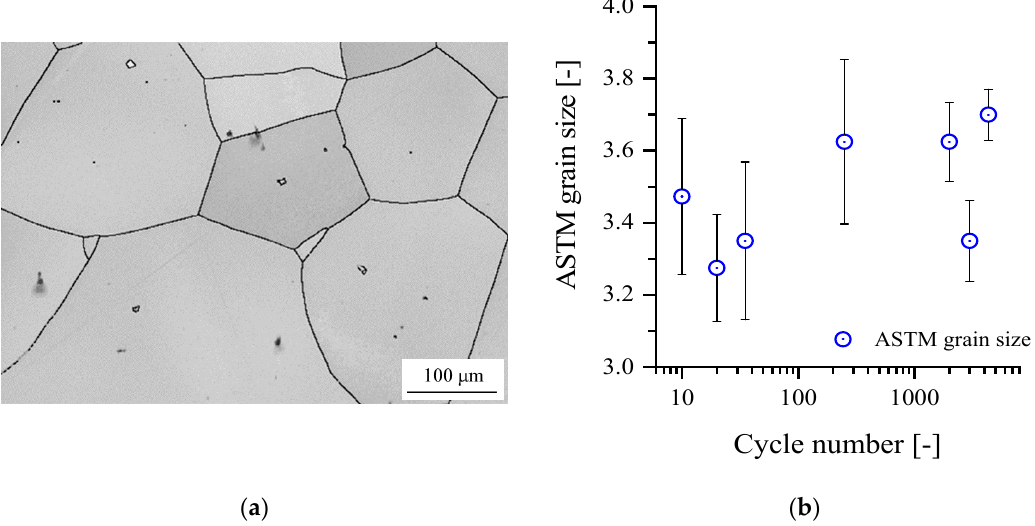
Figure 6. Electron backscatter diffraction (EBSD) image (band contrast image, grain boundaries added) of the as-received state ( a ) of and grain size evolution ( b ) in ferritic Crofer ® 22 H.